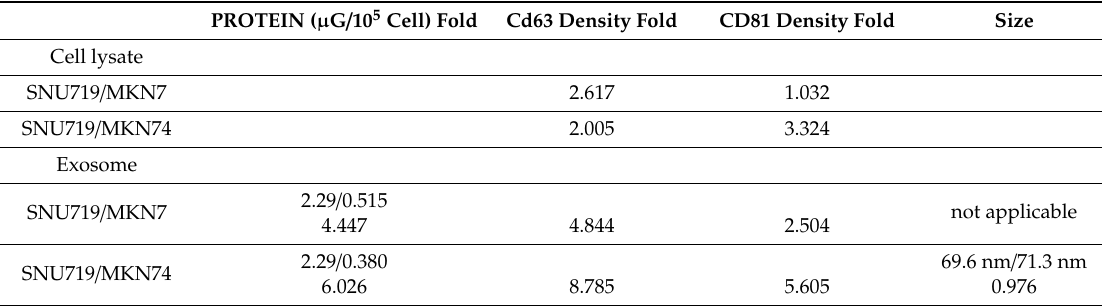
Table 2. Comparison of protein concentration and exosome size between EBVaGC and EBV-negative GC cell